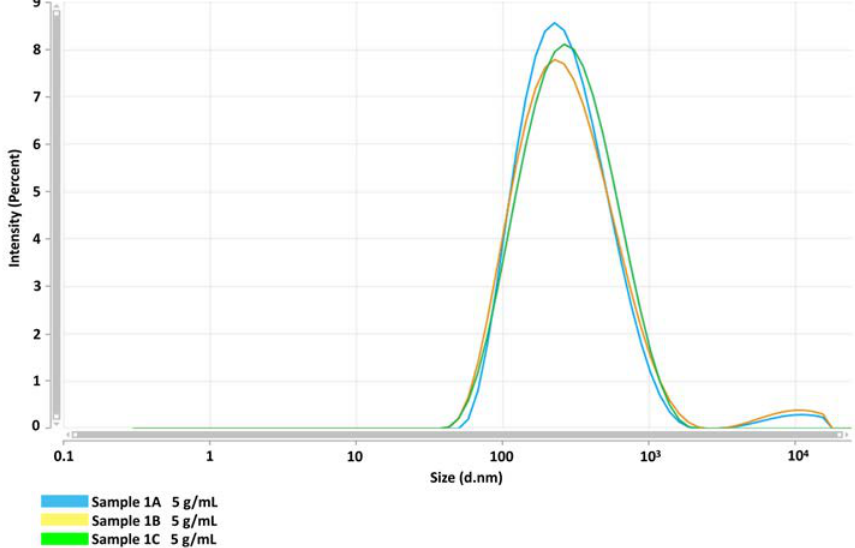
Figure 1. Size distribution of GlcNAc NP suspension at 5 g/mL by DLS at a fixed angle of scattering, expressed as Z-average (d.nm). Three independent preparations were carried out to analyse the size and distribution of NPs. Sample 1A (blue line), Sample 1B (yellow line), and Sample 1C (green line).